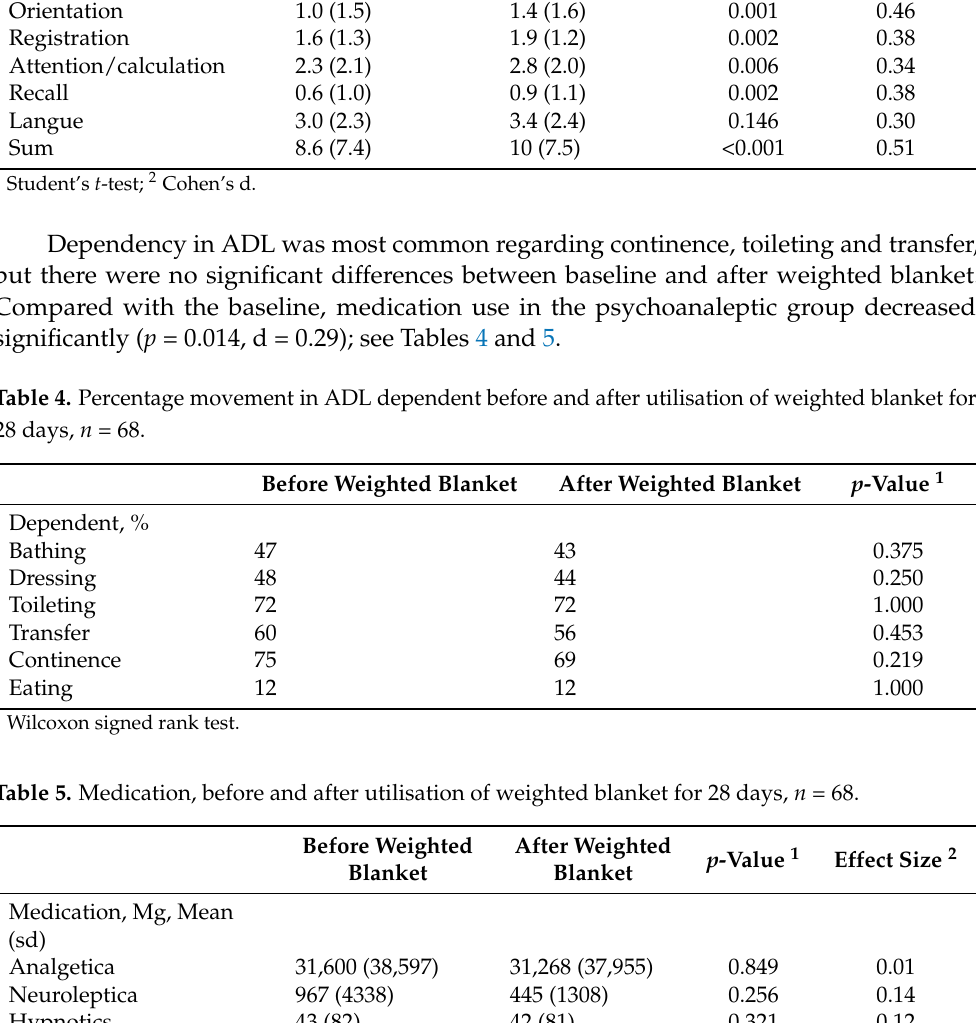
Before Weighted After Weighted Blanket Blanket